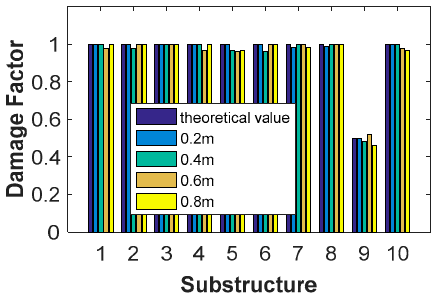
Figure 12. Identification results of single damage at different immersion depths.